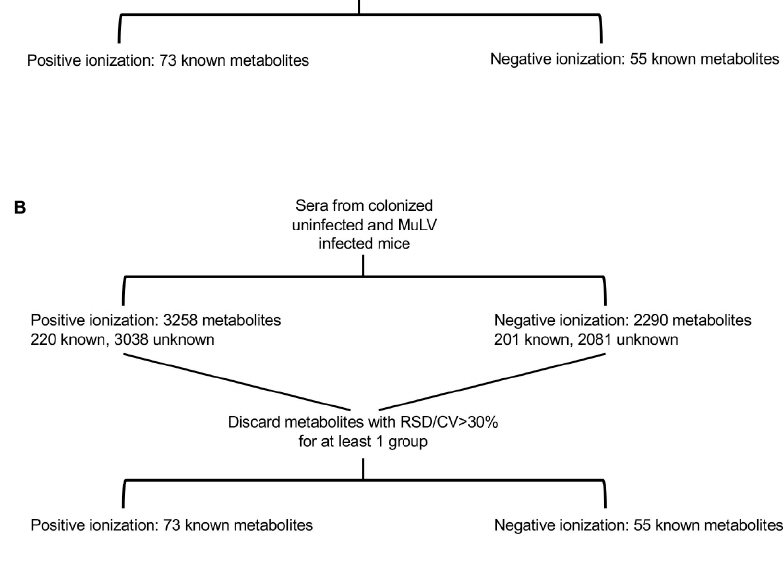
discarded in later comparative analyses. Only identifiable metabolites found between all four groups of mice were kept for subsequent analyses. This includes 73 and 55 known metabolites identified under positive and negative ionization, respectively (Figure 1A,B and Tables S1 and S2). Z-scores for known metabolites can be found in Spreadsheet S1. MuLV infection of GF mice marginally altered the overall metabolomic profile (Figure 2A)